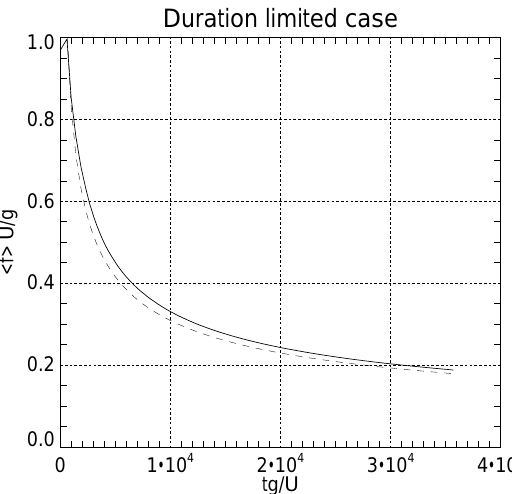
Figure 6. “Magic number” 9 q − 2 p as the function of dimensionless time tg/U for the wind speed U = 10ms − 1 duration limited case – solid line. The target value 1 for the self-similar relation Eq. (32) is represented by the horizontal dashed